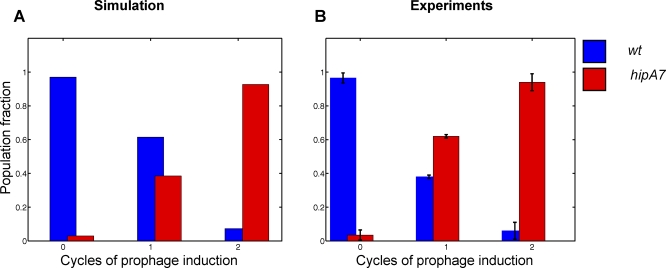
Competition Experiments between Wild-Type and High-Persistence Strains: Simulation and Experiments(A) Simulation of a competition experiment under cycles of prophage heat induction, using the experimental values of the wt and high-persistence hipA7 survival (Figure 1A).(B) Experiments: The wt λcI857KnR and the hipA7 λcI857KnR lysogens were mixed in a ratio of 20:1 and exposed to cycles of prophage-inducing conditions. Each prophage induction cycle was followed by O/N growth in culture. Experiments were repeated three times. Error bars represent the standard deviation between three separate experiments.